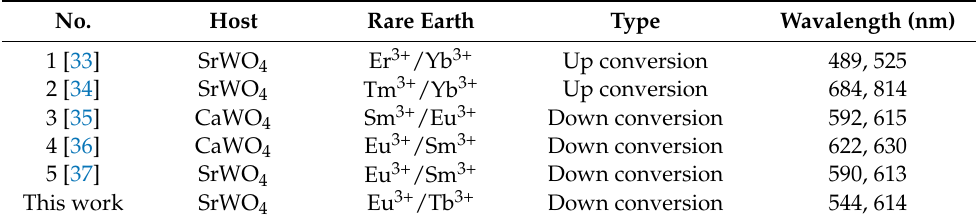
Table 1. Comparison of previous work in tungsten oxide